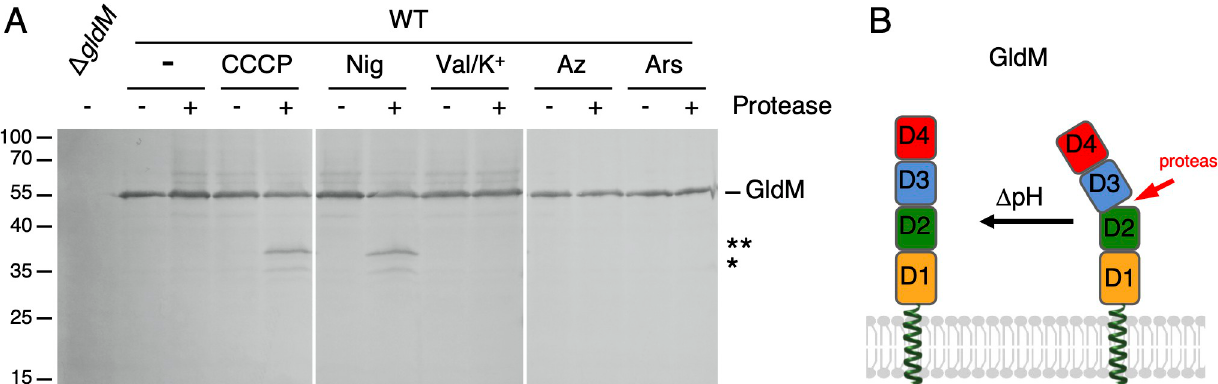
Fig 3. Conformational changes in GldM periplasmic domain in response to the proton gradient. (A) GldM protease accessibility assay. Spheroplasts of WT F . johnsoniae or the Δ gldM mutant were treated (+) or not ( − ) with the trypsin protease and 10 μ M CCCP (PMF inhibitor), 7 μ M nigericin ( Δ pH inhibitor), 40 μ M valinomycine/K+ ( Δ φ inhibitor), 1.5 mM sodium azide, or 20 mM sodium arsenate (F 1 F 0 ATPase inhibitors). GldM was analyzed by SDS-PAGE and immunoblot with anti-GldM antibodies. The full-length GldM protein is indicated, as well as degradation products ( � and �� ). The molecular mass markers (in kDa) are indicated on the left. (B) Schematic model of GldM conformational transition dependent on the proton gradient. WT, wild-type.